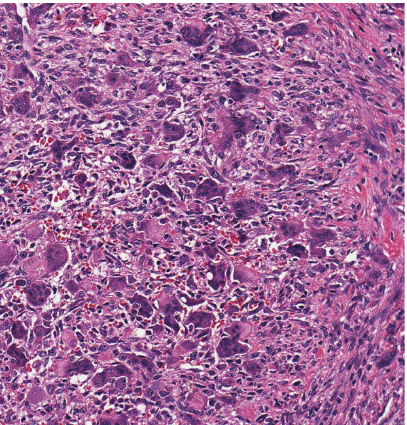
Figure 11: Hematoxylin and eosin stain histological